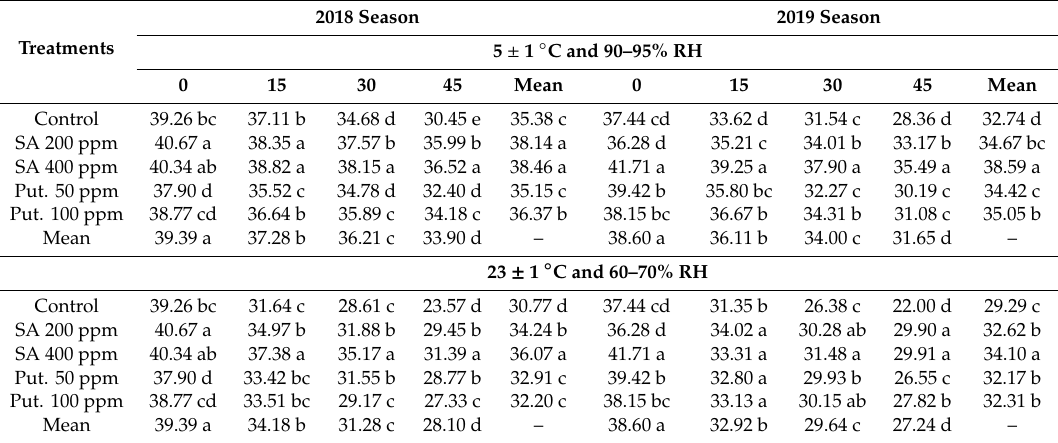
Table 7. E ff ect of salicylic acid (SA) and putrescine (Put) on Ascorbic acid (mg / 100 mL juice) of Murcott mandarin fruit at harvest and 15, 30, and 45 days of storage during 2018 and 2019